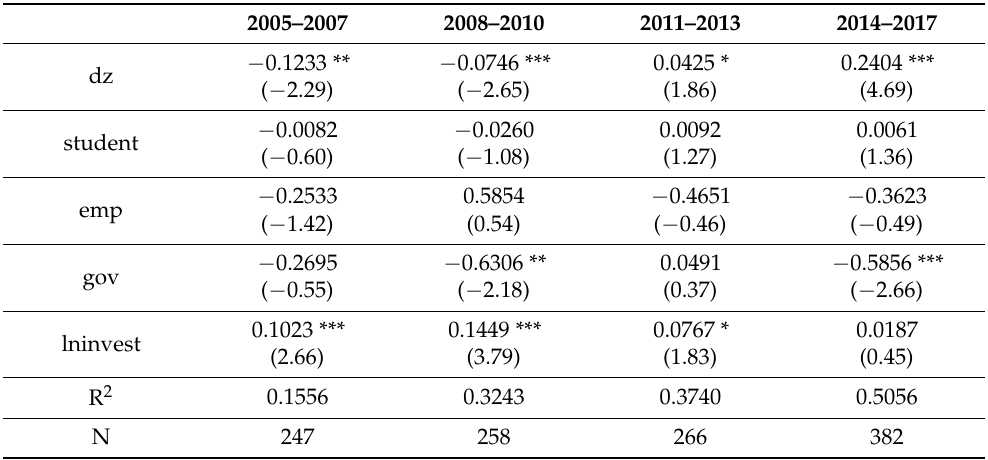
Table 7. Impact of the established frequency of development zones on economic